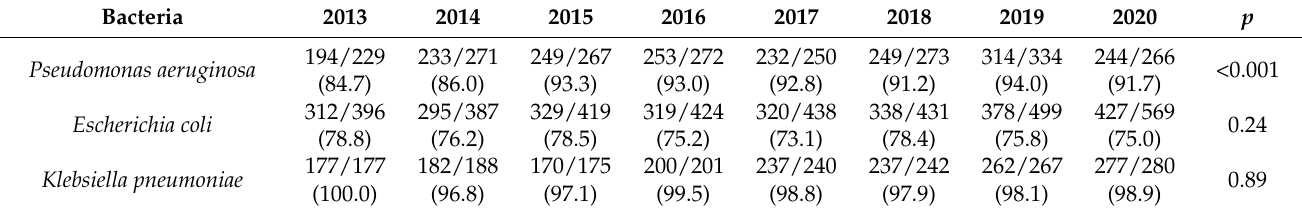
Table 5. Susceptibility of each bacterium to levofloxacin over an 8-year period. Bacteria